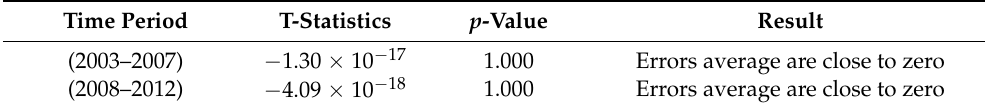
Table 8. The results of the Student’s t -test.